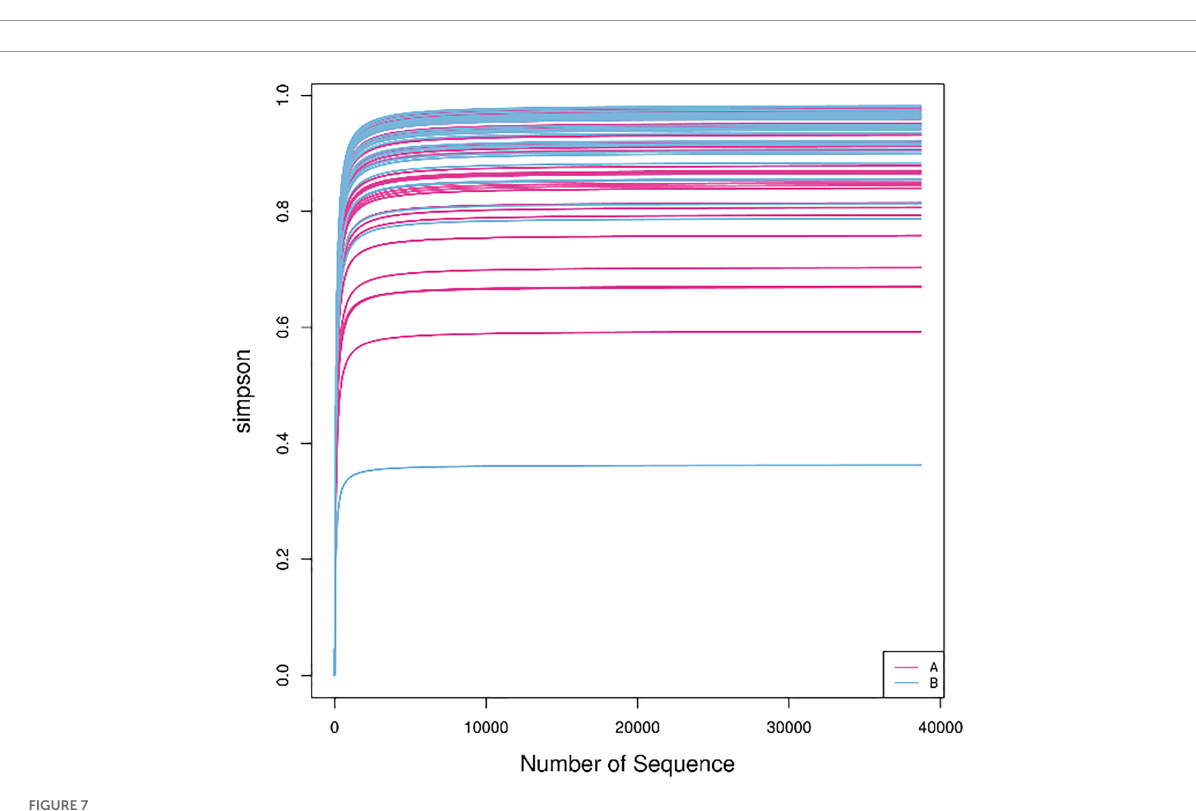
FIGURE7 Dilution